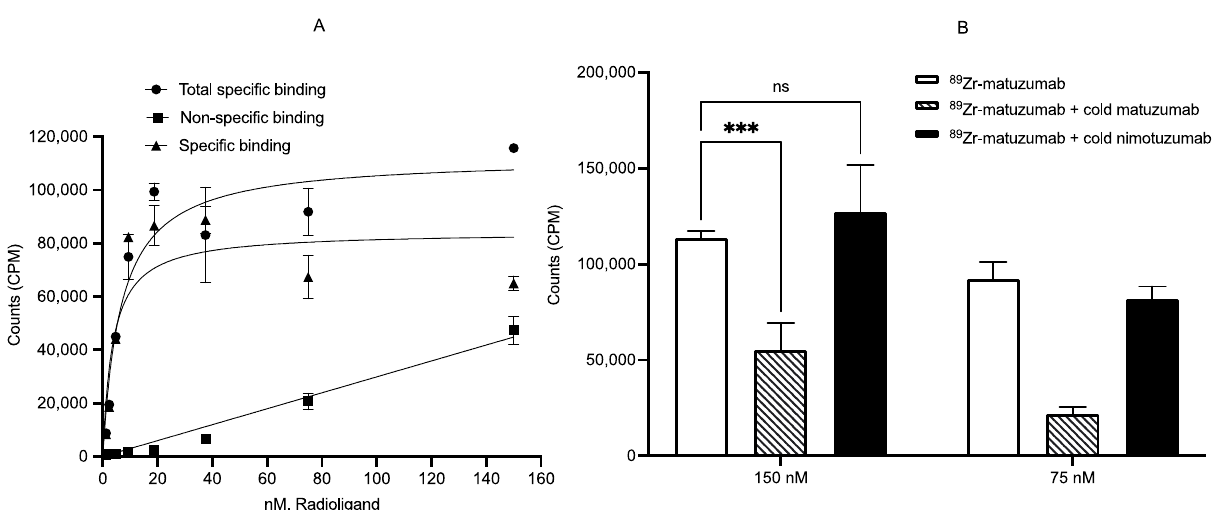
Figure 2. Radioligand binding assay of 89 Zr-matuzumab in DLD-1 cells. ( A ) Total, nonspecific, and specific binding of 89 Zr-matuzumab in DLD-1 cells. The specific binding was gotten from the subtraction of nonspecific binding from total binding. ( B ) Epitope-specific competitive binding of nimotuzumab and matuzumab to EGFR. Binding of 89 Zr-matuzumab to EGFR was not blocked by excess of nimotuzumab indicating epitope specificity (ns = not significant ( p > 0.05), *** = highly significant ( p <<< 0.05)).